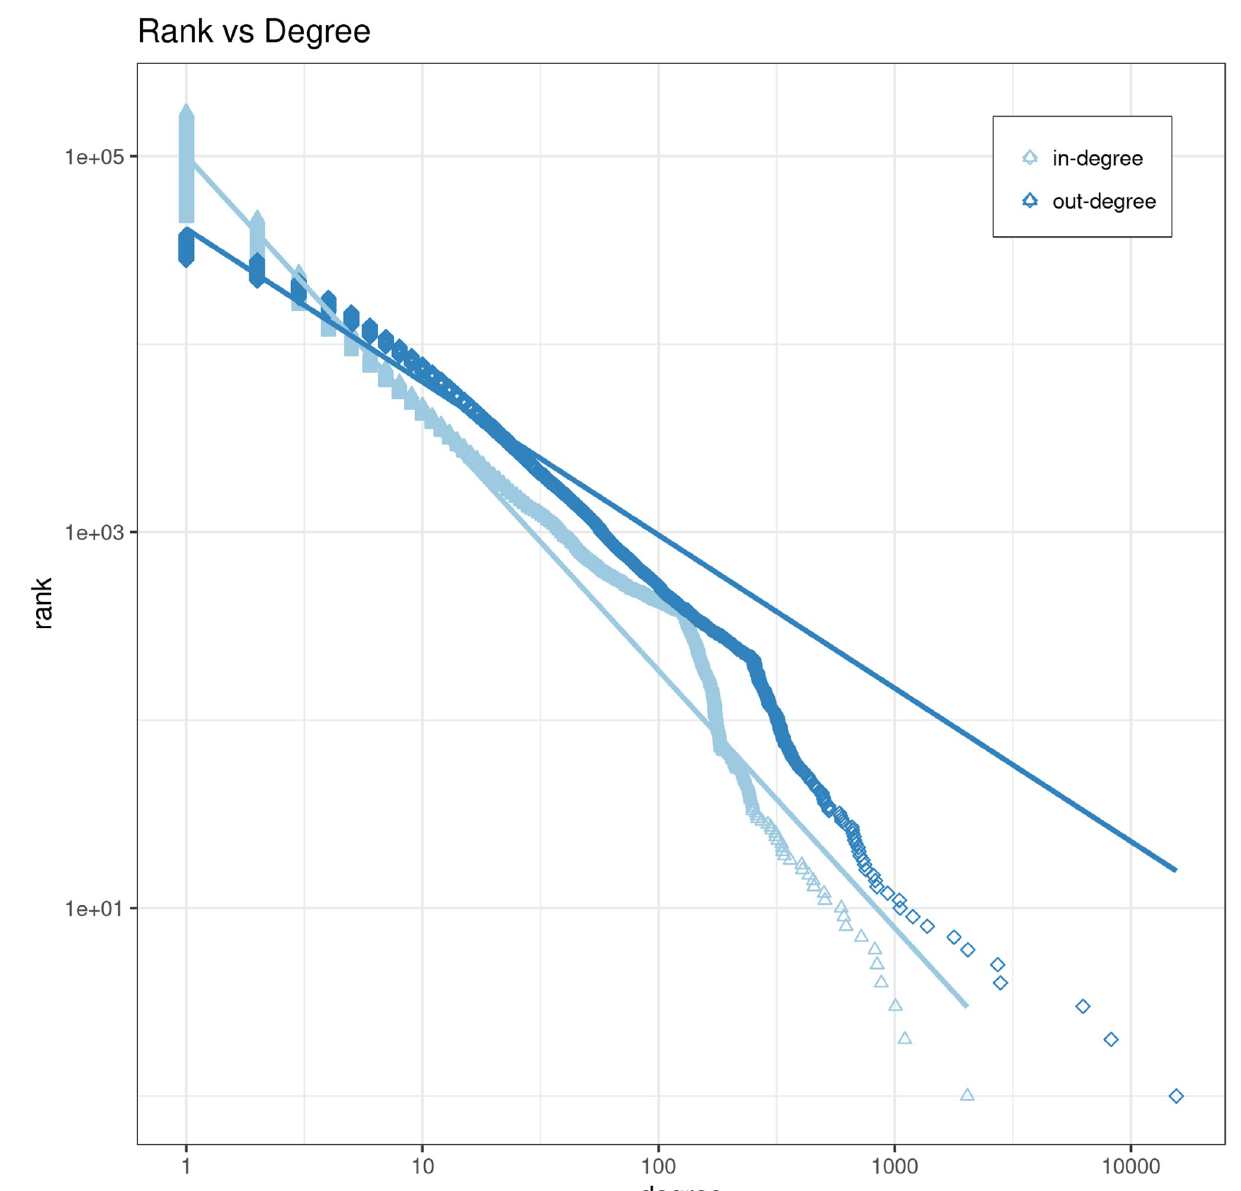
Fig 3. Size-rank plot of degree distribution of the host-aggregated sGHW